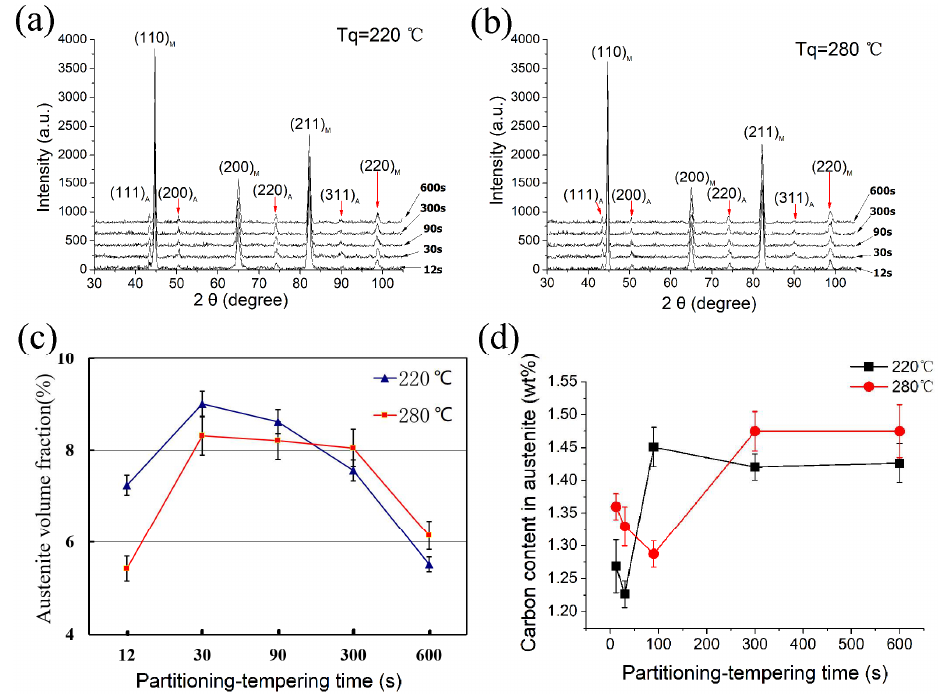
Figure 8. The XRD patterns ( a , b ), volume fraction of the austenite ( c ) and carbon content in austenite ( d ) in the quenching-partitioning-tempering specimens as functions of the quenching temperatures and partitioning-tempering time.